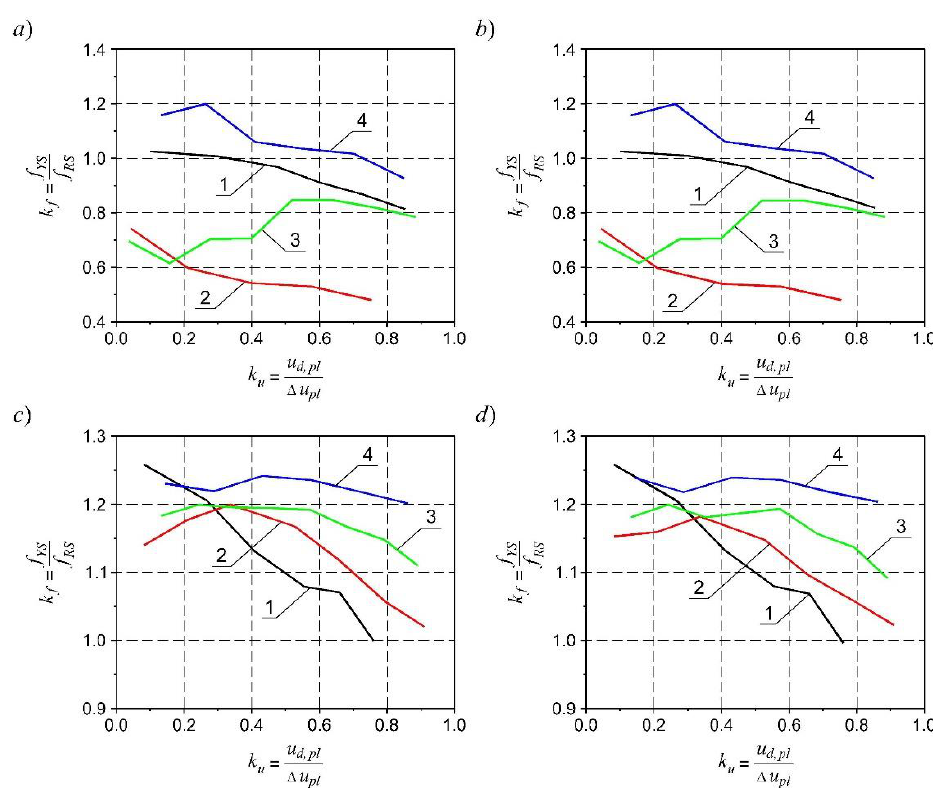
Fig. 10. Influence of value of supports displacements at transition to the phase of hardening on slab displacements: a – in section 2–2 at 2–2 with nonlinear stiffness distribution of supports on the sides of the slab; d – in section 1–1 with nonlinear stiffness distribution of supports on the sides of the slab; 1 – for 50000 kN/m/m g  ; 3 – for for 1 el